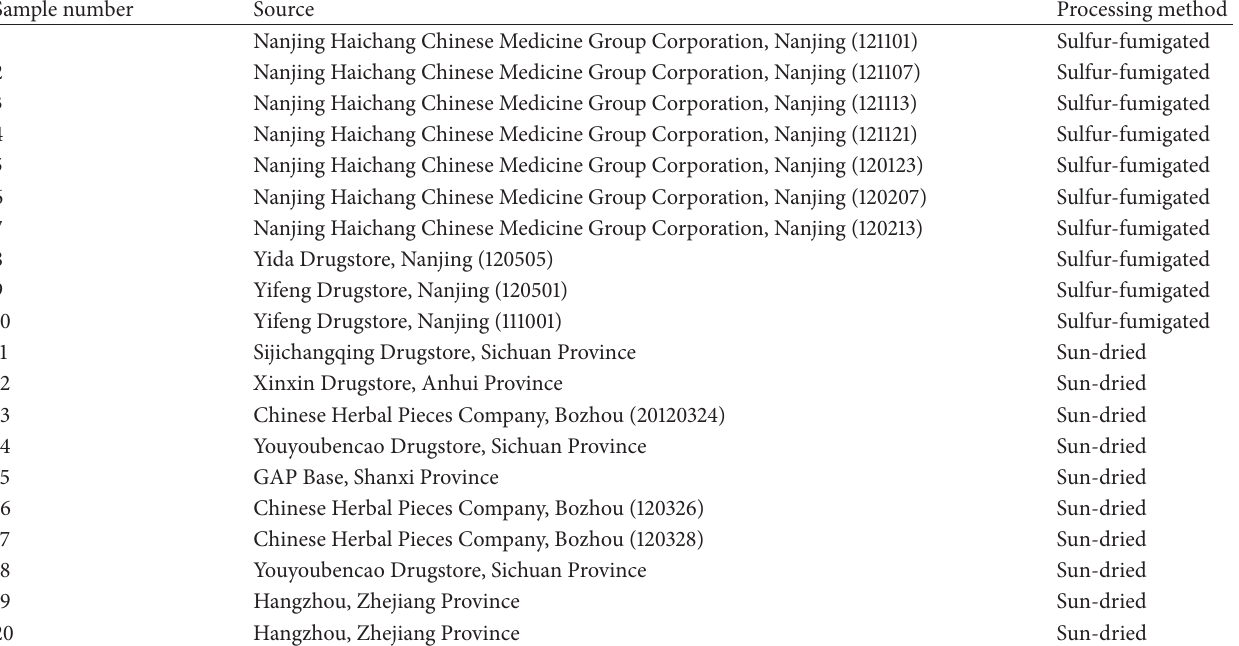
Table 1: Sources and processing methods of twenty batches of Paeoniae Radix Alba